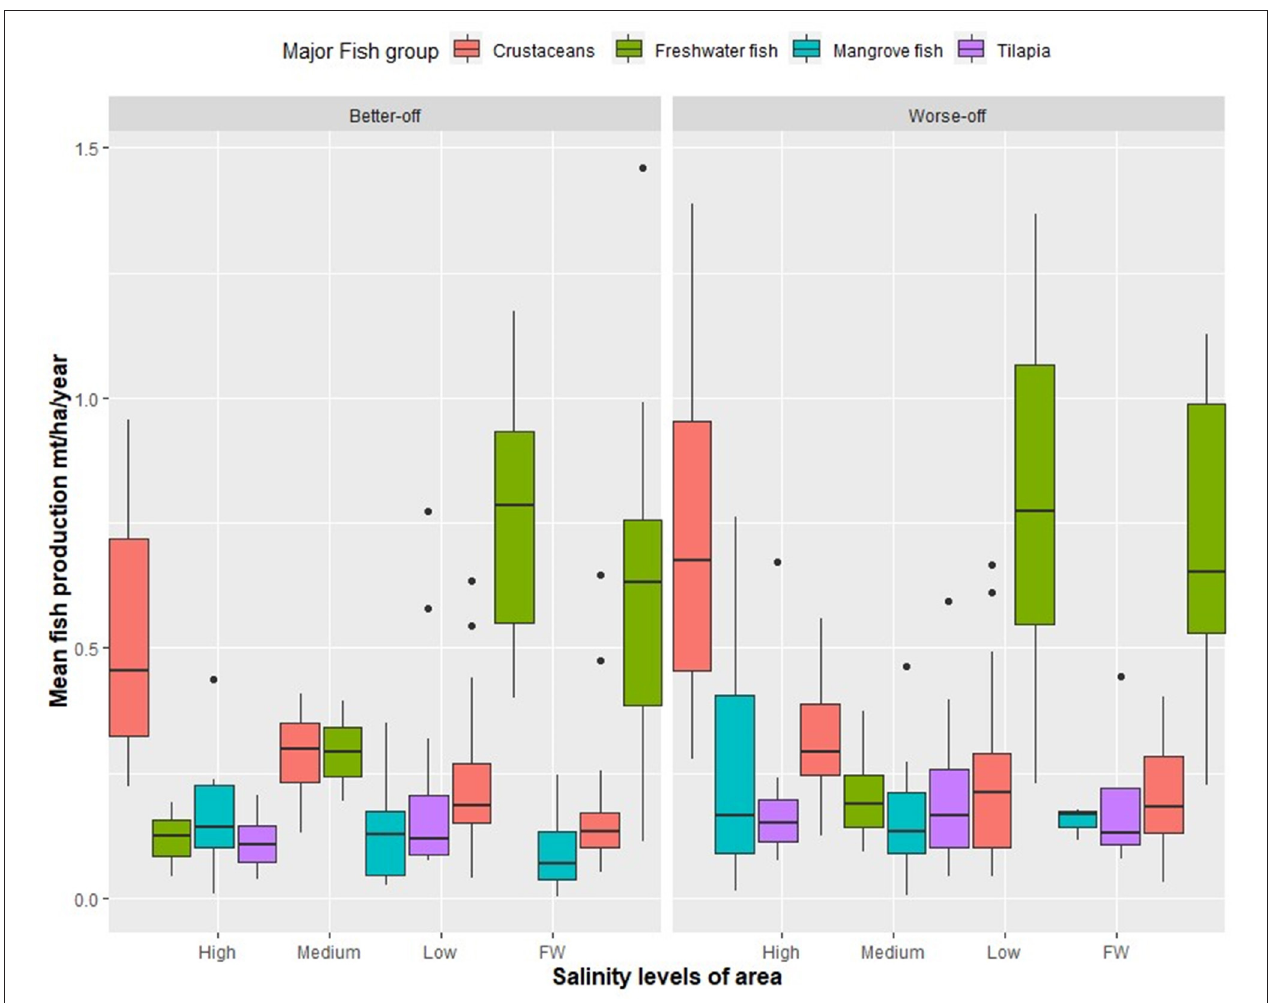
TABLE 2 | Share of households (%) with access to gher by salinity zone and socioeconomic grouping in south-west Bangladesh. Household well-being Salinity level (no. of HH) Mean total land holding